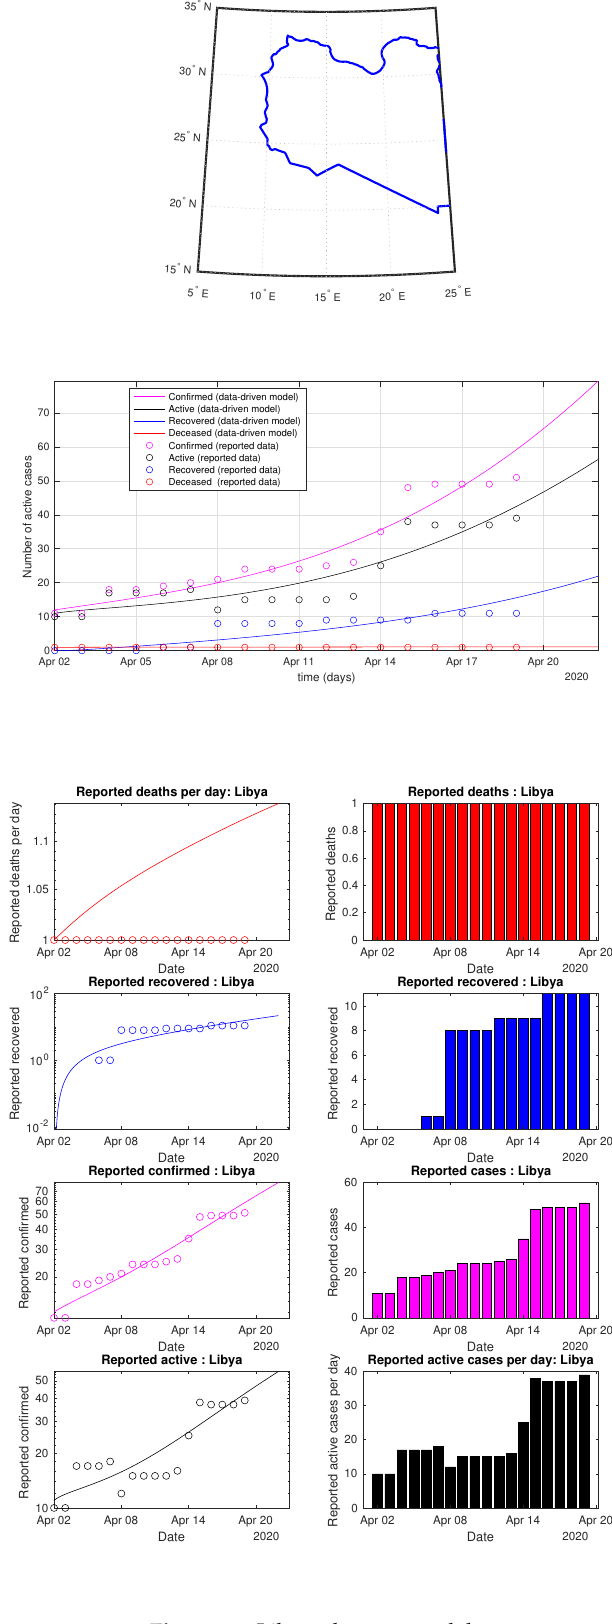
Figure 69. Libya: data vs.